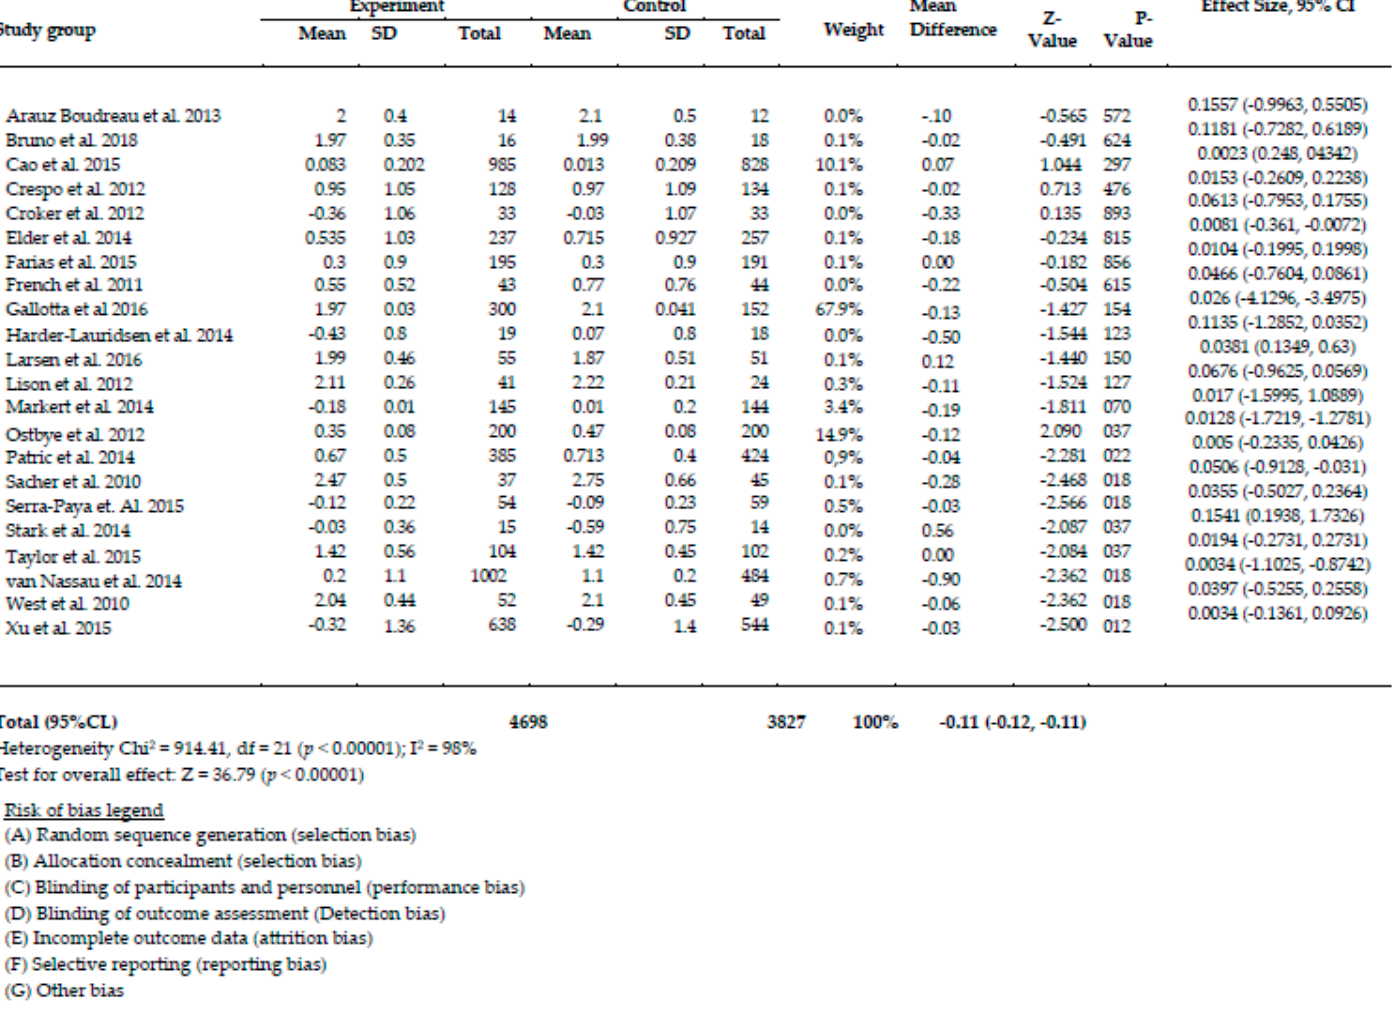
Figure 3. Meta-analysis results